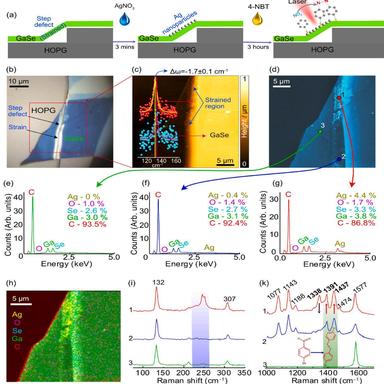
a) Experimental scheme representing the process of AgNO3 solution deposition, Ag nanoparticles formation, and functionalization with 4-NBT, b) Optical image of GaSe on HOPG after modification by AgNO3, c) AFM and d) SEM images of the region of interest. The inset in c shows the Raman spectra with a down-shift of the A'1 peak for the strained region. (e-g) EDX spectra represent non-strained region e), strained region f), and strained region with Ag nanoparticles. h) Elemental map obtained by EDX. i) Raman sp